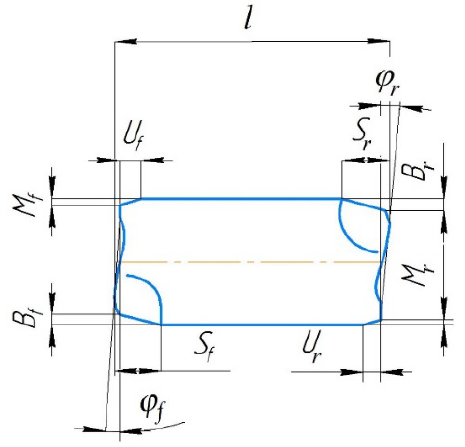
Figure 10. Basic parameters for evaluating the workpieces shape deviation The results of the conducted measurements of the relative average values for the geometric shape distortions of the workpieces obtained by cutting in the stamp of the new design are presented in Table